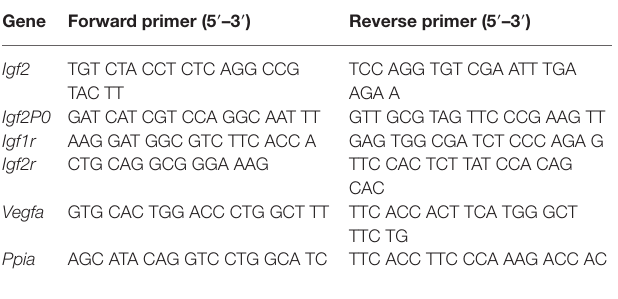
TABLE 1 | Quantitative real-time PCR